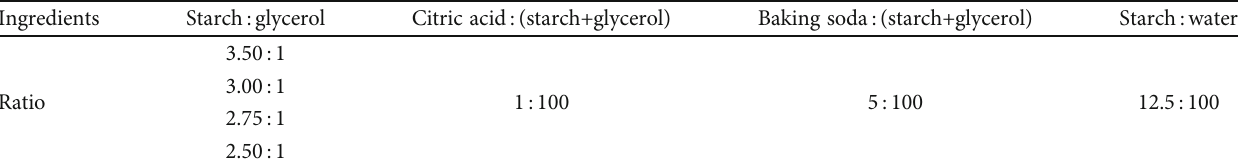
Table 1: The ratio of the raw material composition of plastic specimens.